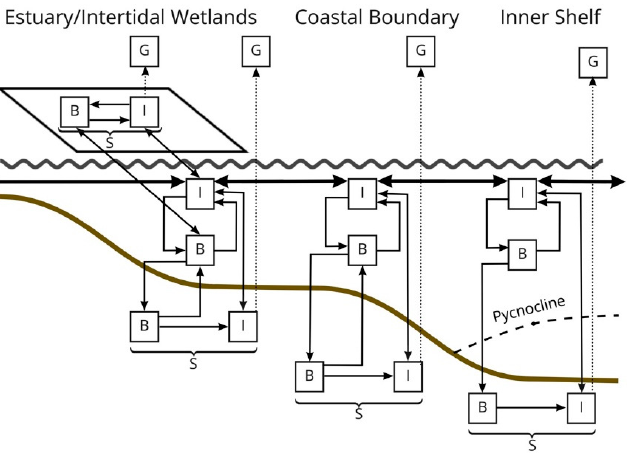
Figure 1. Schematic that describes the role of benthic fluxes as potential sinks of nitrogen in Breton Sound as influenced by both subtidal sediments and intertidal wetlands by burial and denitrification. (B = biogenic nutrients; I = Inorganic nutrients; G = gaseous nutrients; S = nutrient